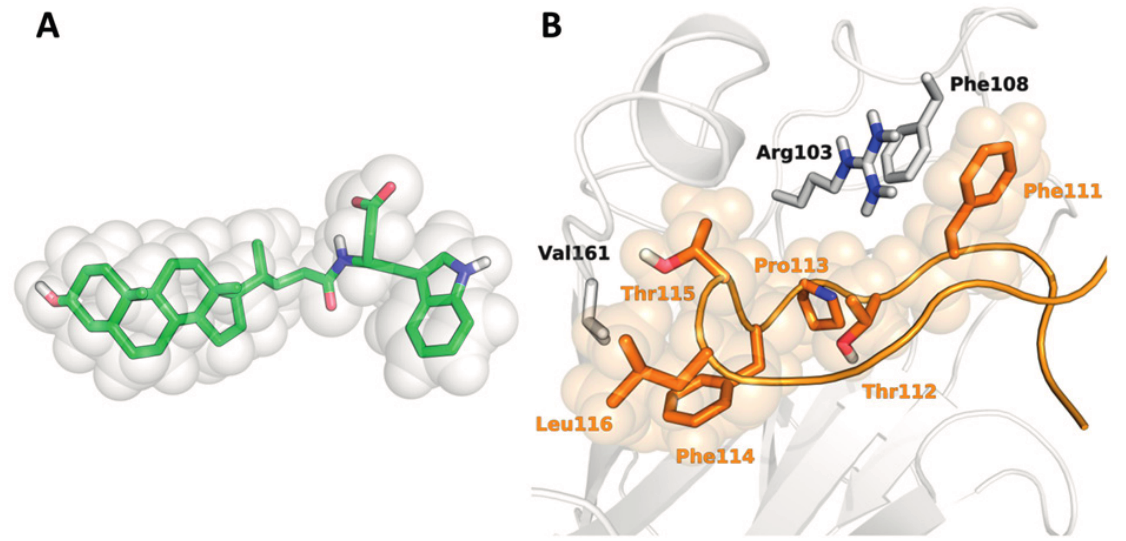
Figure 5. ( A ) 3D representation of UniPR129 in its minimum-energy conformation with its shape represented as a set of van der Waals spheres; and ( B ) X-ray structure (PDB: 3HEI) of EphA2 (white carbons) in complex with ephrin-A1 (orange carbons). The shape of the G-H loop of ephrin-A1 involved in the interaction with EphA2 is depicted with van der Waals spheres. Table 1. EF values calculated at 2% and 5% for the shape-screening simulations. Template